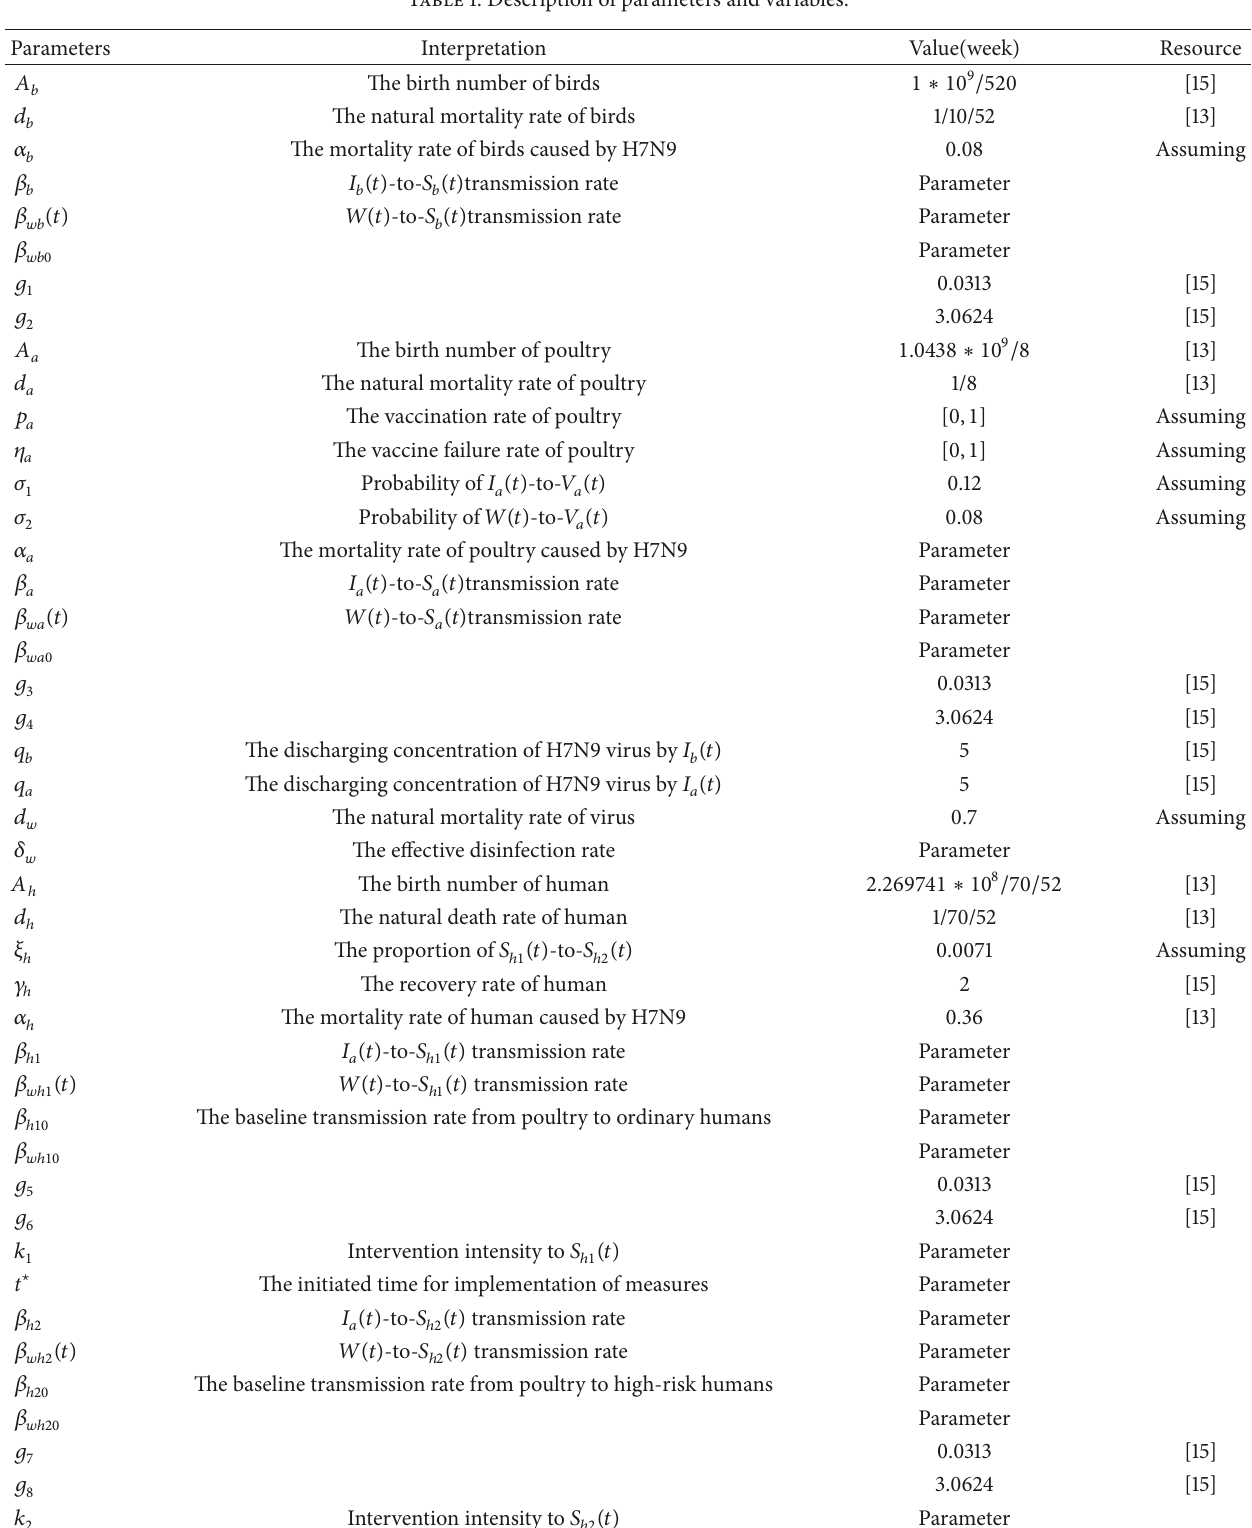
Table 1: Description of parameters and